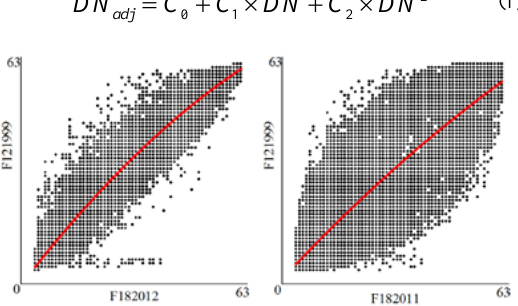
Figure 3. Urban changes of Shandong in 1994, 2002, and